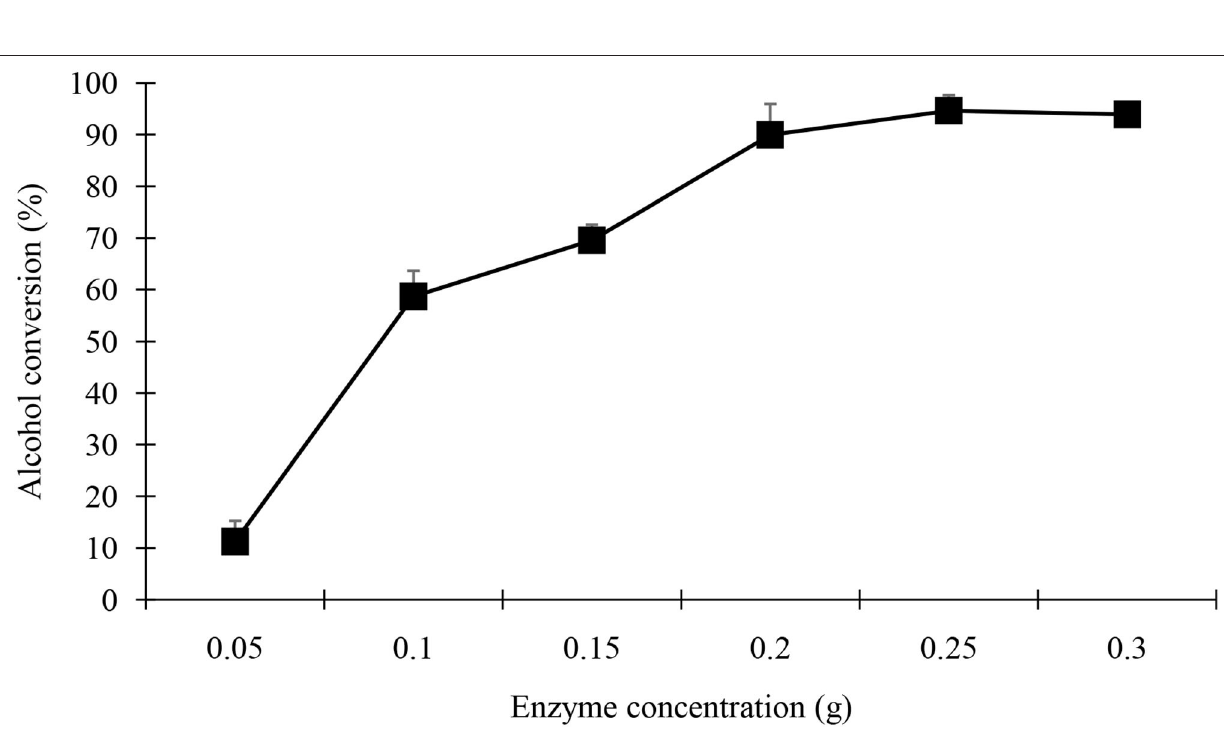
Frontiers in Sustainable Food Systems |